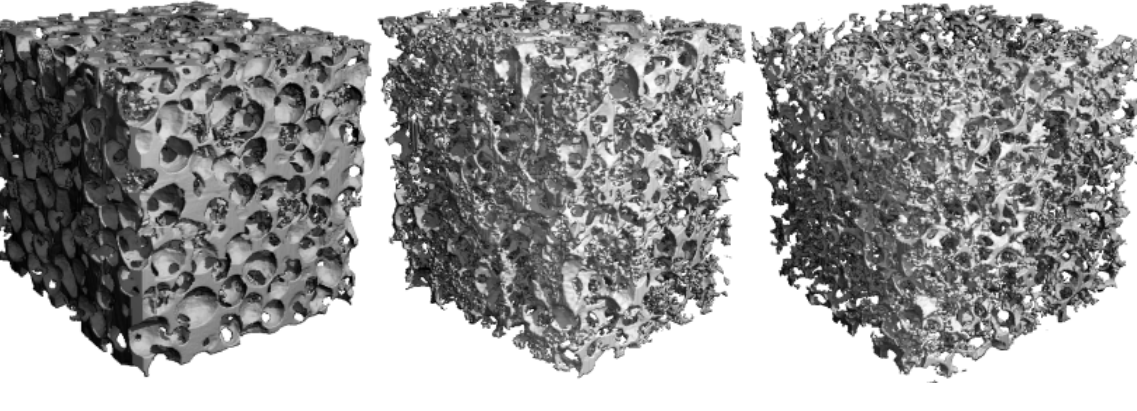
Figure 8. µCT images of foams made by infiltration at 14 psi, for preforms compacted at (left) 32 MPa, (middle) 39 MPa and (right) 50